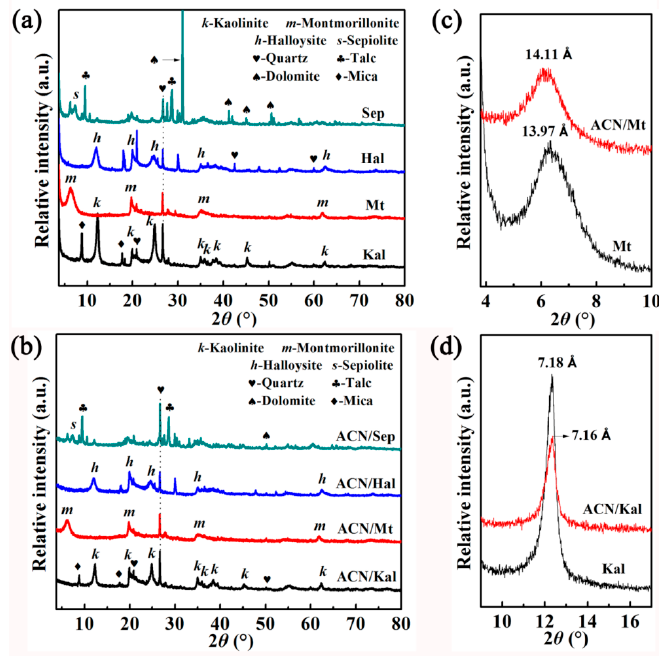
Figure 1. XRD patterns of ( a ) the raw clay minerals, ( b ) ACN / clay mineral hybrid pigments, the corresponding partial enlarged view of ( c ) Mt and ( d ) Kal before and after incorporation of ACN.